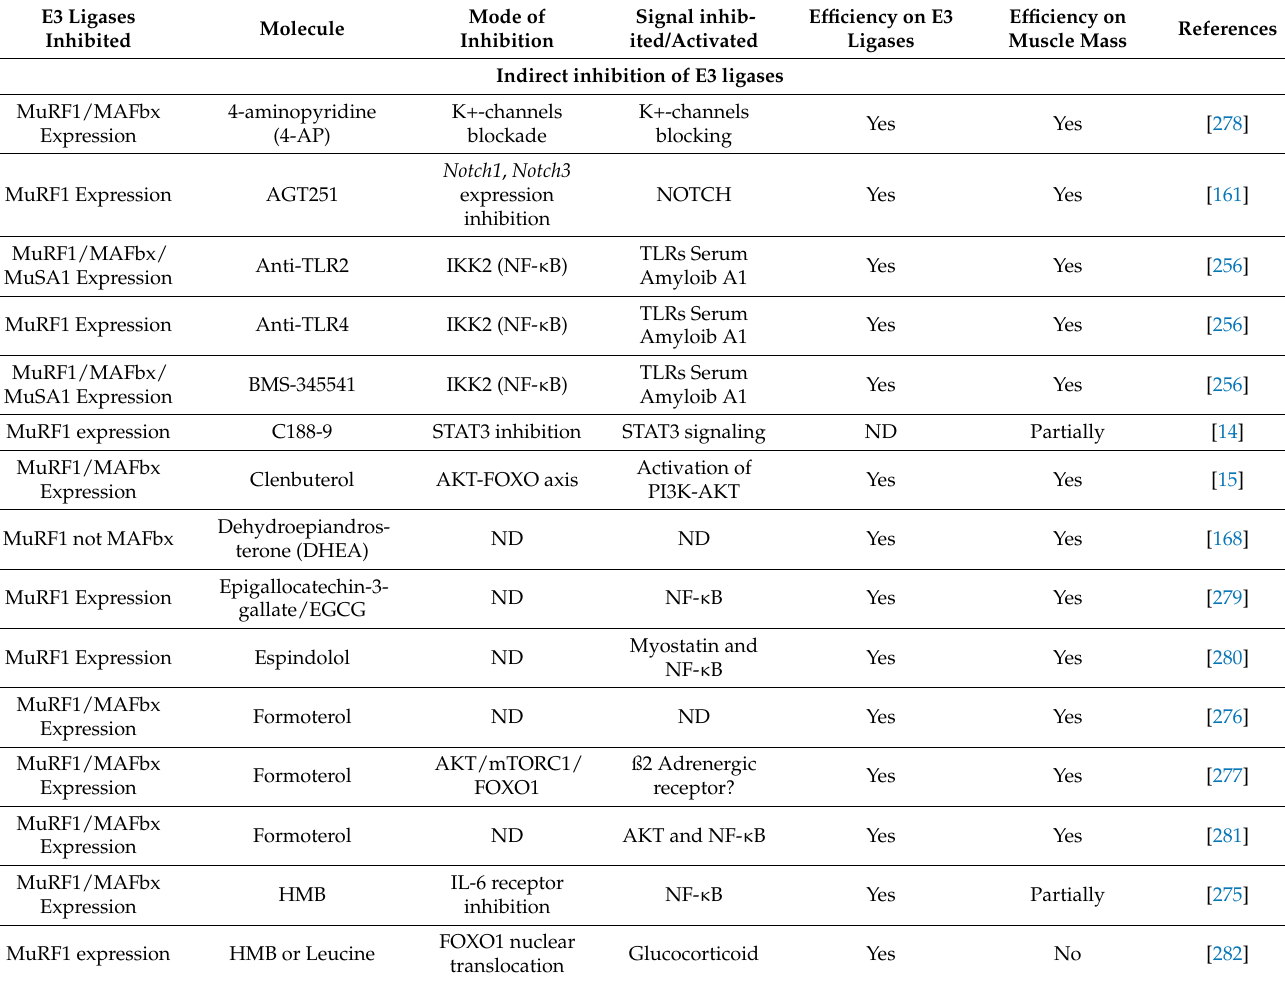
Table 2. Treatments influencing E3 ligases expression and/or